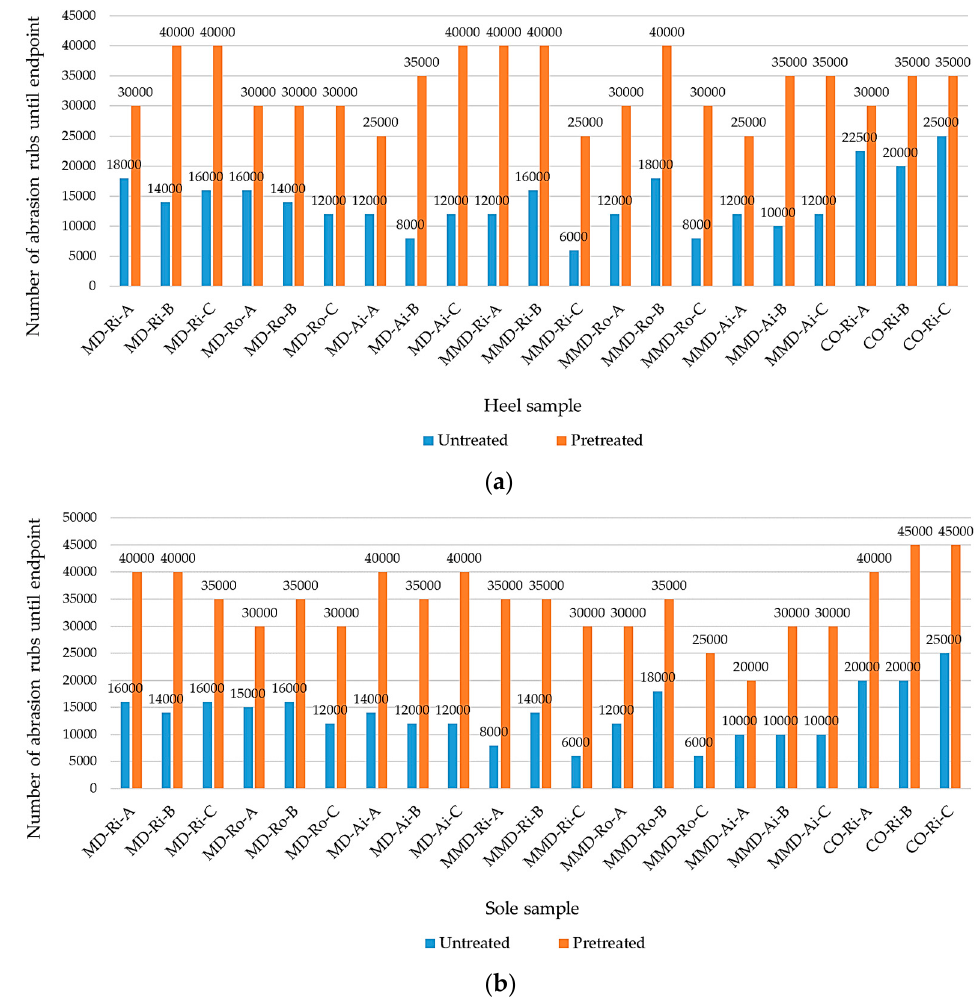
Figure 12. Abrasion resistance of the untreated and pretreated plain knits sampled from ( a ) the heel of the socks; ( b ) the sole of the socks, determined before and after five repeated washing and drying cycles (where MD—modal fibers, MMD—micro modal fibers, CO—cotton fibers; Ri—ring spun